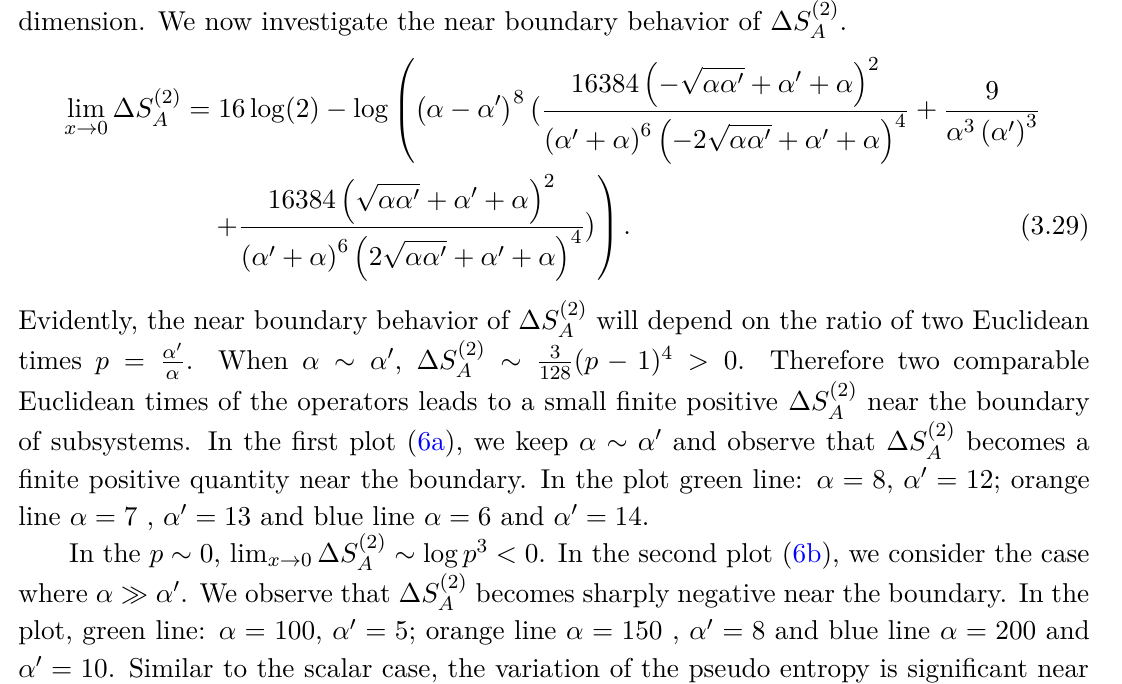
far away from the boundary. This property is similar to the case of a scalar field in d = 4 dimension. We now investigate the near boundary behavior of ∆ S (2)